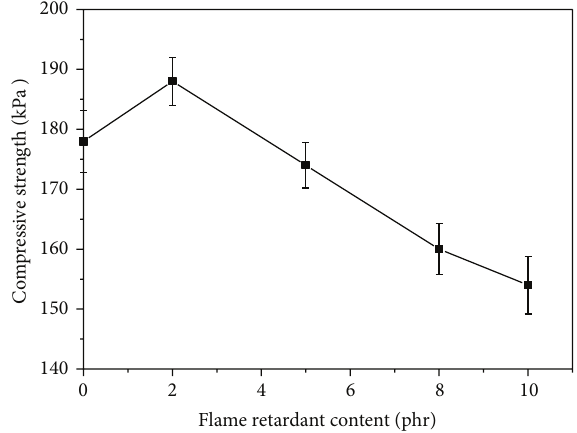
Figure 1: IR spectra of KH-550 and DPTP.